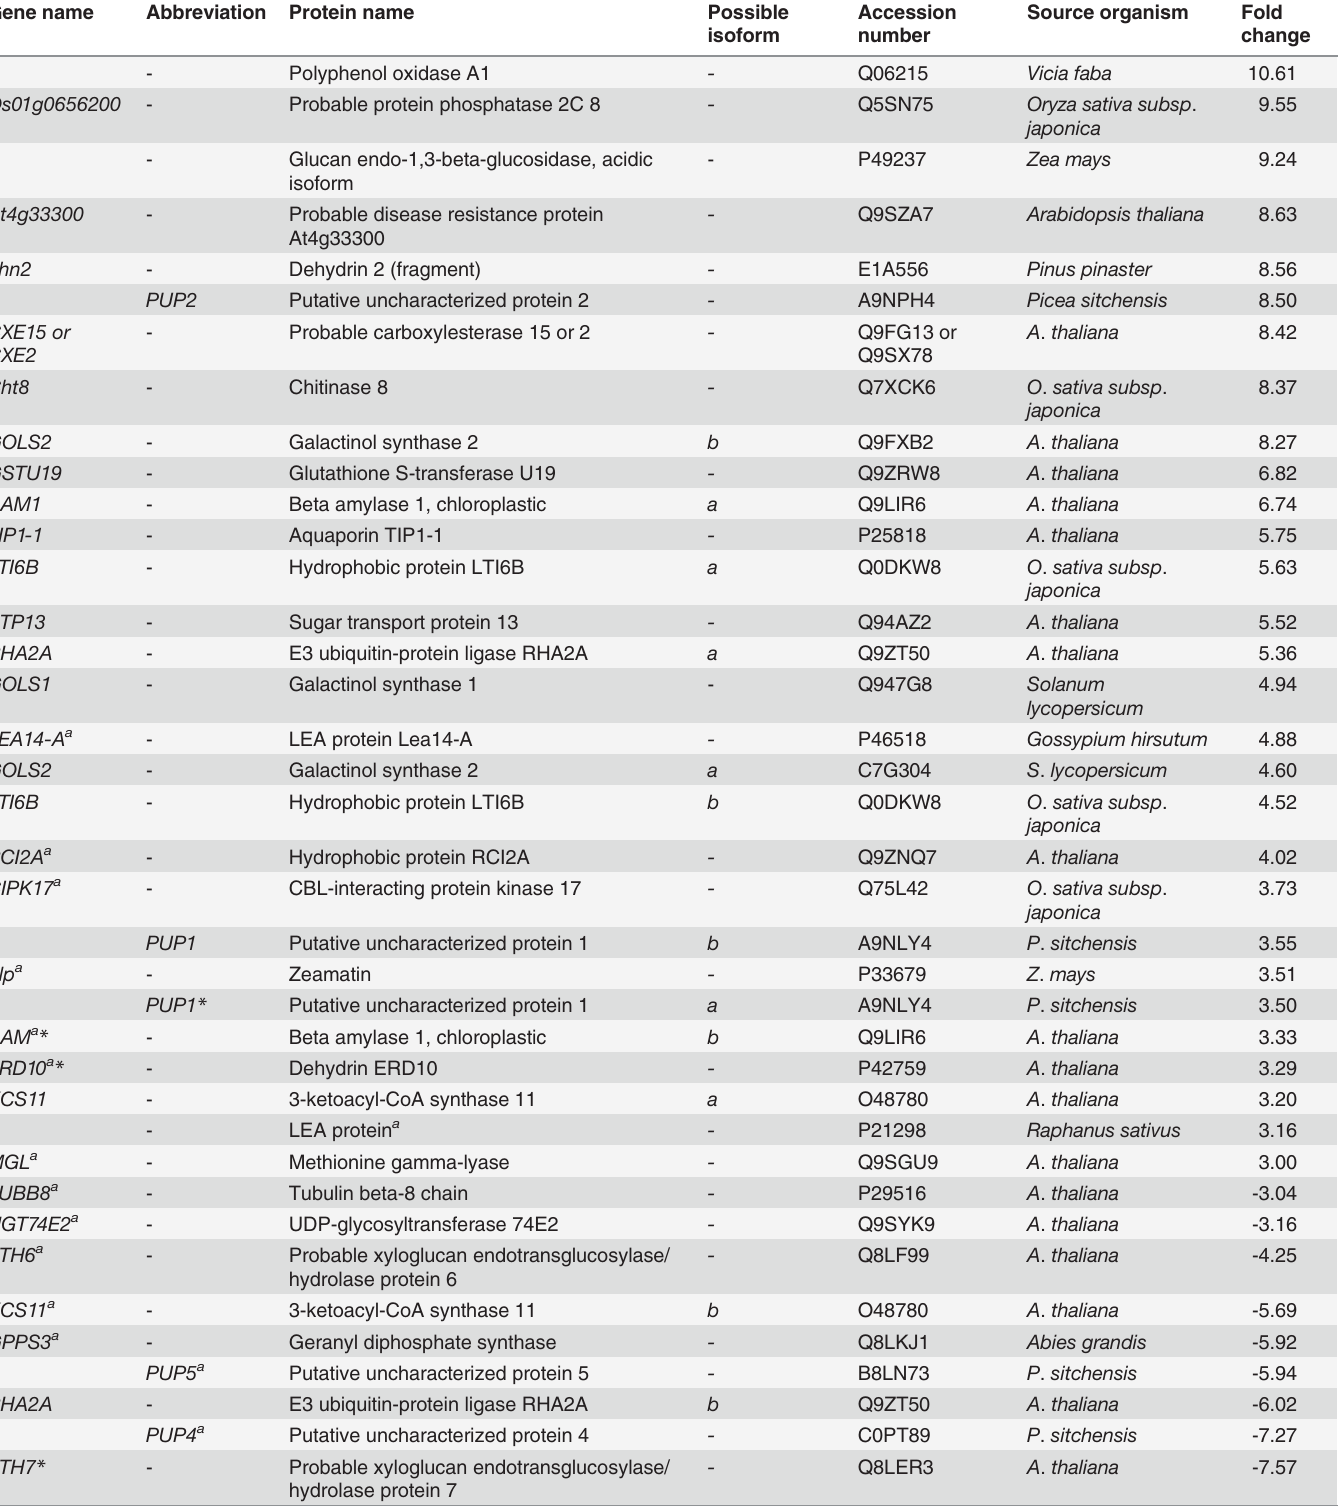
Table 3. Genes for validation derived from the DEGseq analysis; sorted by log 2 fold change in descending order. Gene